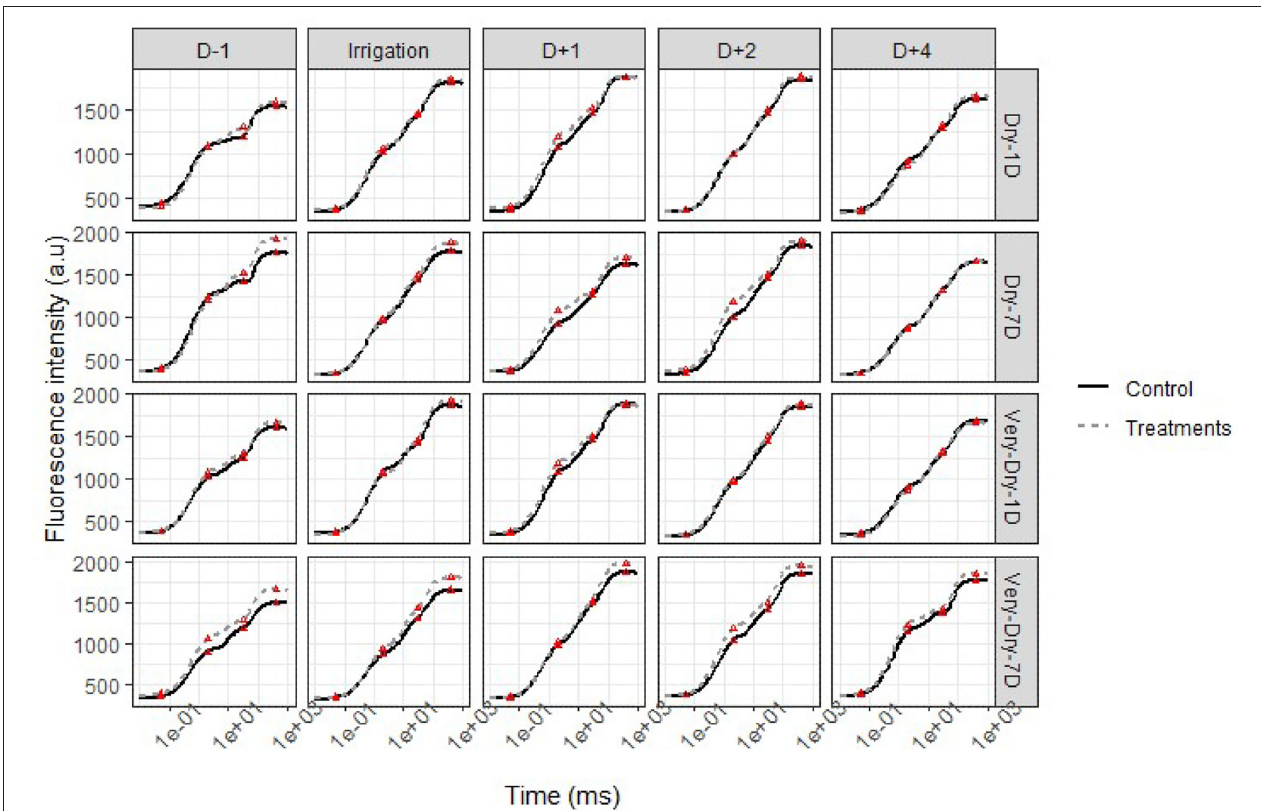
FIGURE 5 | OJIP transient curves of chlorophyll a fluorescence for potato under stress (solid lines) and optimal water supply (dashed lines) conditions—second stress in the winter 2019 experiment. Each point represents the mean of four independent measurements. The red triangles ( 1 ) denote the position of the OJIP points on the